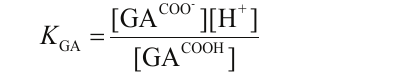
Fig. 1 – Adsorption isotherms of D-GA at varying initial pH values (a) experimental points (b) Langmuir fitting (c) Freundlich fitting (d) Radke-Prausnitz fitting (Baobei Wang et al. Combined adsorption and ion exchange of D -glyceric acid using a strong basic resin: equilibrium, kinetics, and